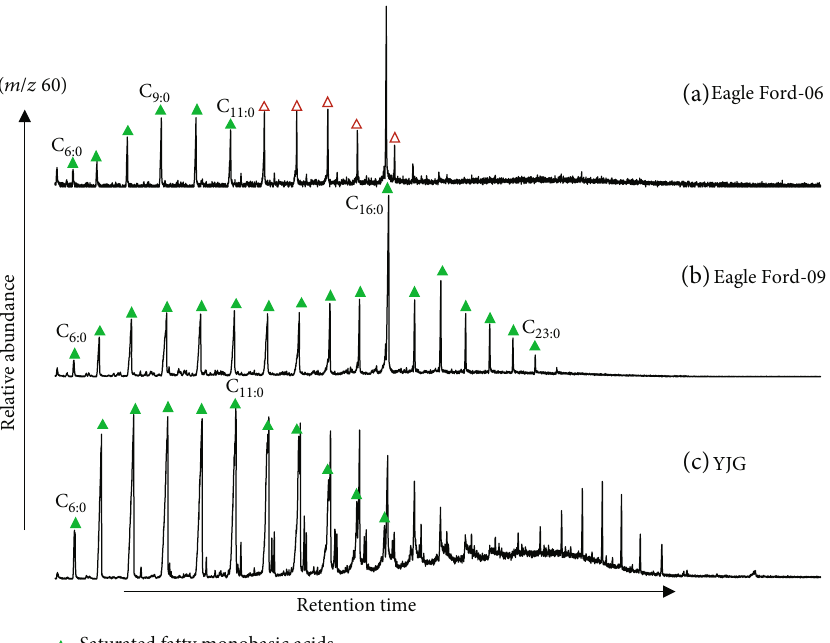
Figure 6: m / z 60 mass chromatograms of the organic compounds in diethyl ether ((a) Eagle Ford-06, (b) Eagle Ford-09, and (c) YJG).